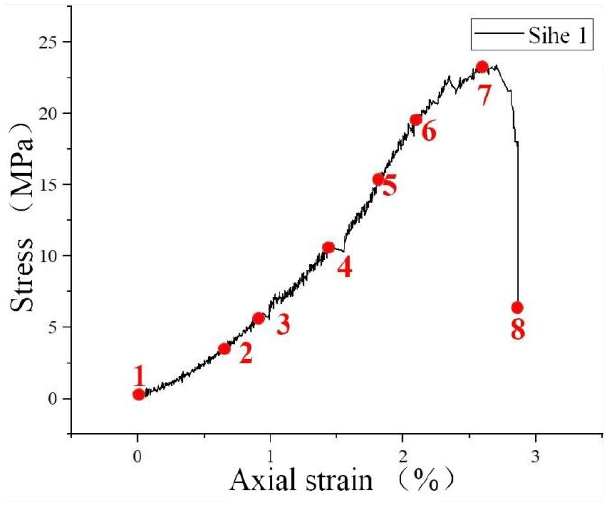
Figure 5. Stress–strain curve and corresponding stage of CT scan. were analysed to determine the changes in area and